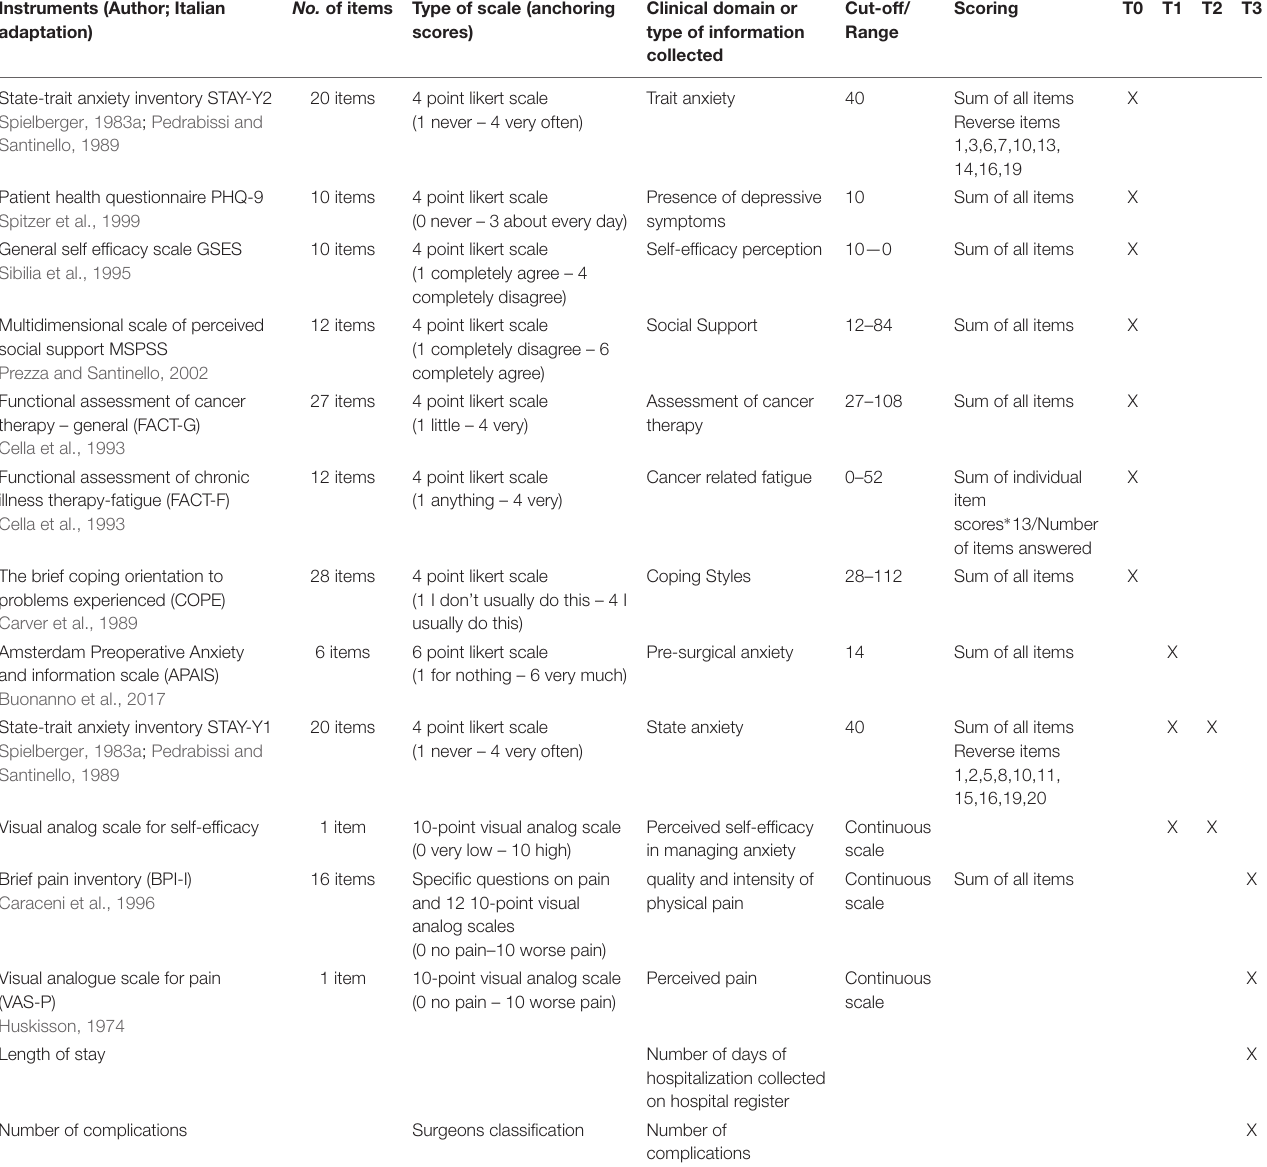
TABLE 1 | List of questionnaires and variables collected at each stage of the